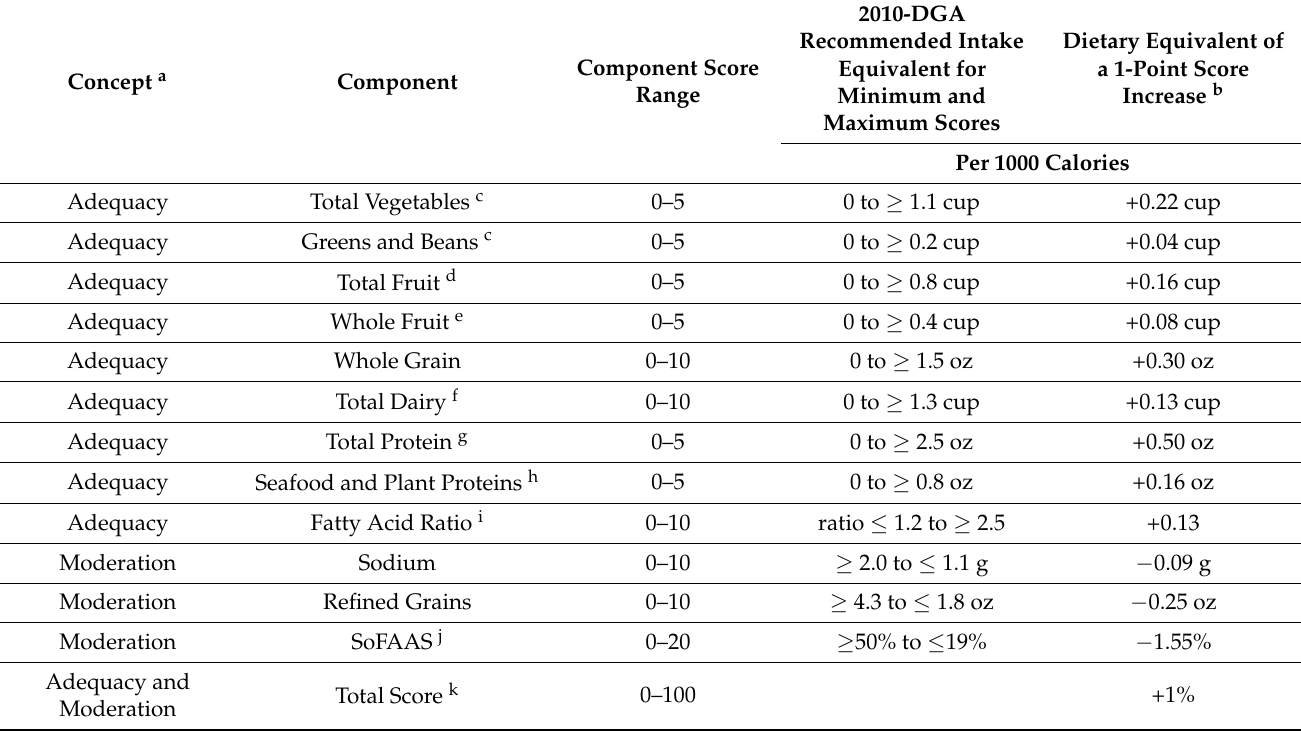
Table 1. The healthy Eating Index 2010 component and total scores are density measures for dietary intake, as assessed by adherence to the 2010 Dietary Guidelines for Americans